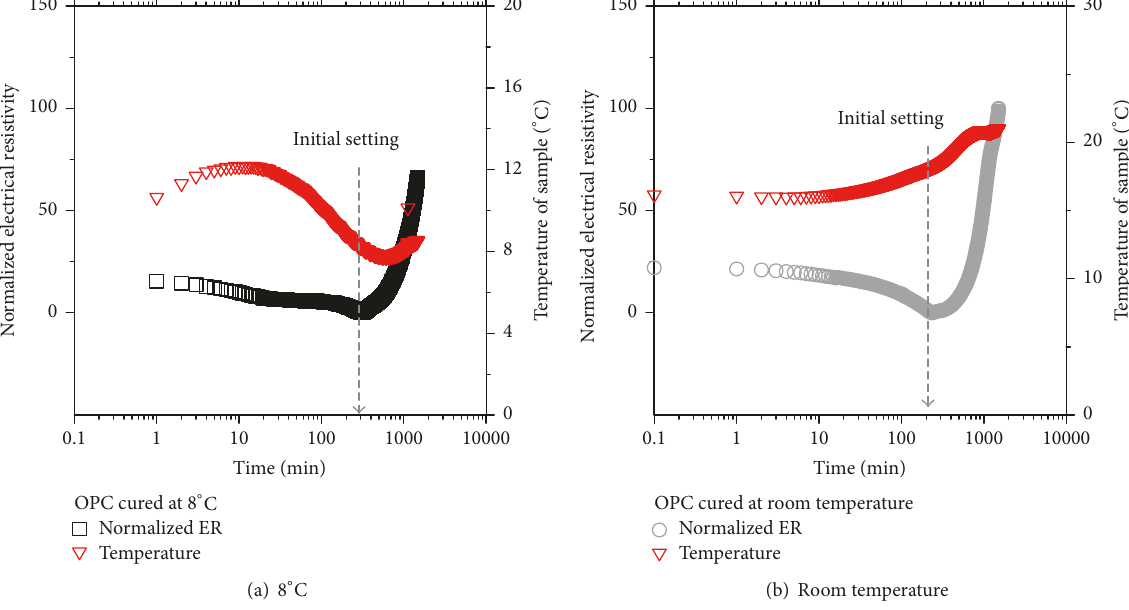
Figure 4: Sample temperature